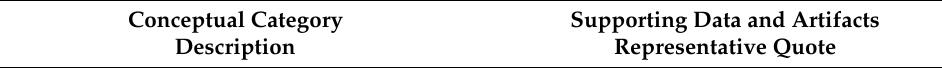
Table 3. Conceptual categories (actions) of transference with supporting data, artifacts, and represen- tative quotes. An expanded table is provided in the Supplementary